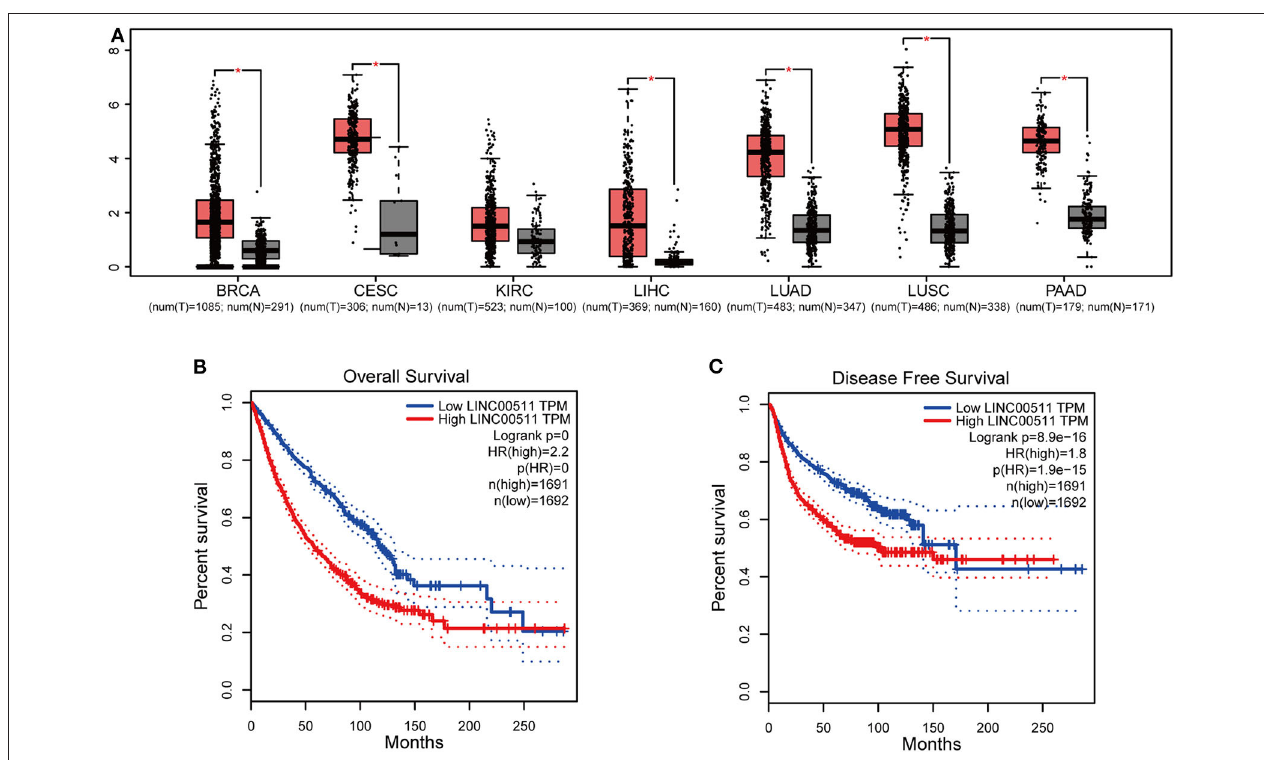
FIGURE 4 | The expression level and prognostic significance of LINC00511 analyzed by cancer public database. (A) LINC00511 expression profile across tumor samples and adjacent normal tissues from GEPIA (* P < 0.01). (B) Overall survival and disease-free survival plots of LINC00511, LIHC, STAD, GBMLGG, BRCA, CESC, KIRC, LIHC, LUAD, LUSC, PAAD were included in ( n = 3383, Log-rank P < 0.001). (C) Disease-free survival plots of LINC00511, LIHC, STAD, GBMLGG, BRCA, CESC, KIRC, LIHC, LUAD, LUSC, PAAD were included in ( n = 3383, Log-rank P <